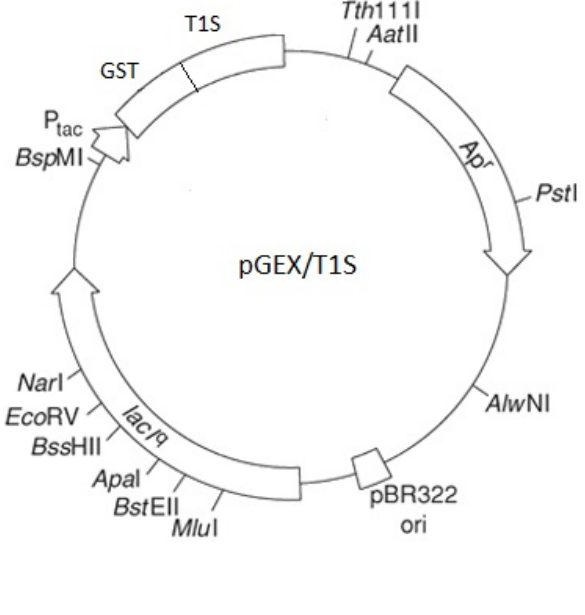
Figure 10. Schematic diagram of the parental plasmid pGEX/T1S. Expression of the T1, D311E and K344R lipase gene were done as the fusion